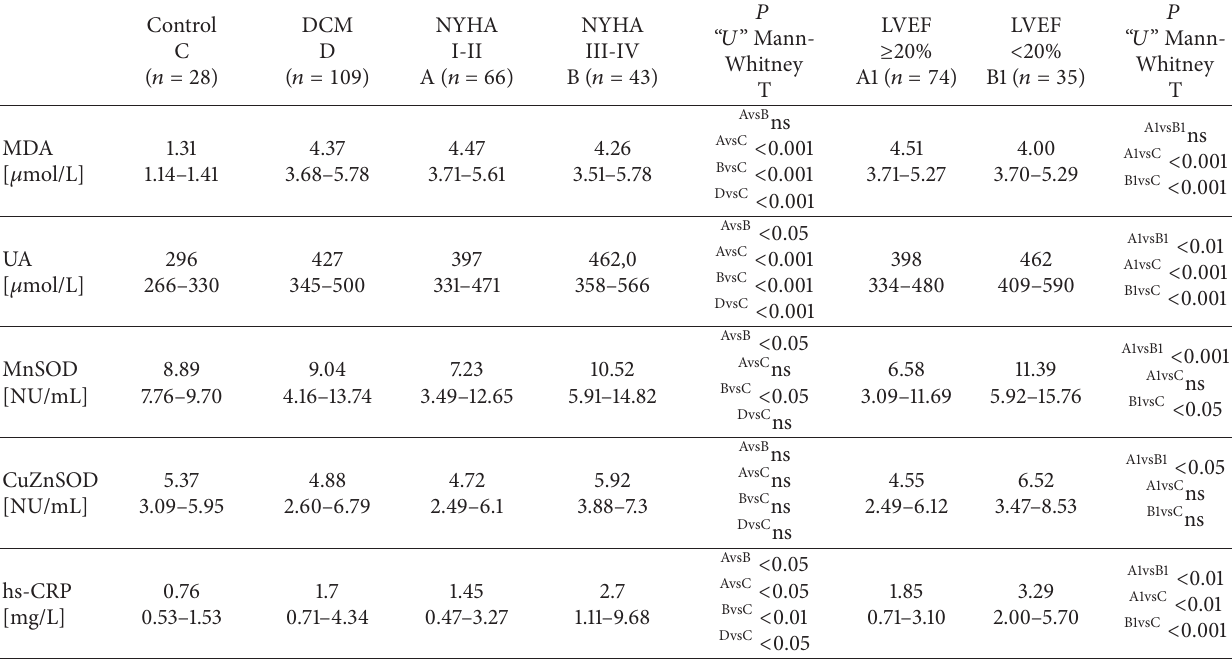
Table 4: Redox biomarkers and hs-CRP in healthy controls and all DCM patients and with division of them into groups depending on NYHA class and LVEF.